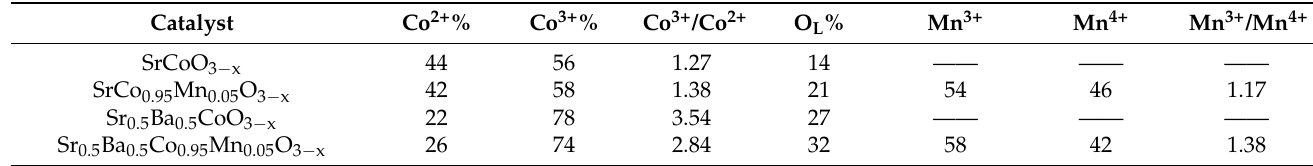
Table 1. Proportion of Co, O, Mn elements in the catalyst.